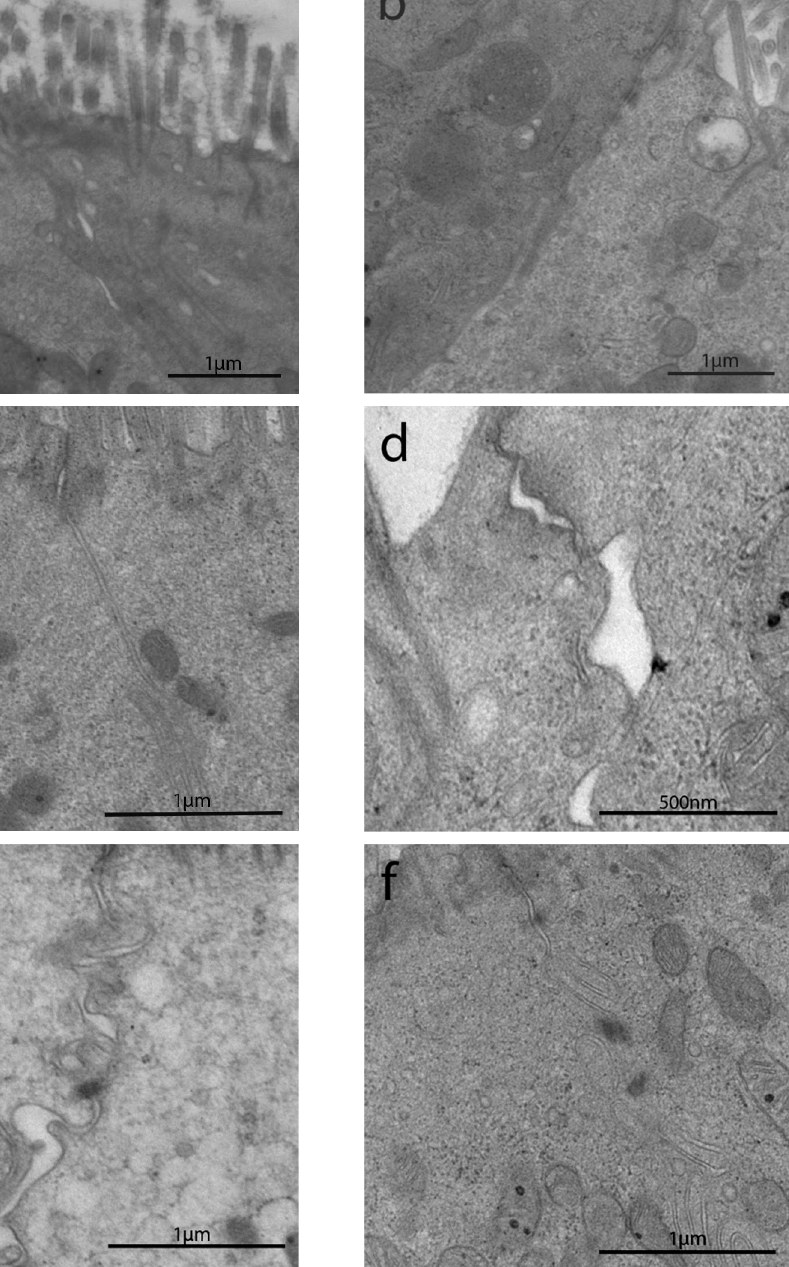
Figure 3. TEM images of apical junctional complexes (AJC) in IBS-like disorders: uCD ( a ); tCD ( b ); WA ( c ); NCGS ( d ); Ni ACM ( e ); controls ( f ). In particular, TJ gap width did not show significant differences among all groups; AJ gap was significantly more dilated in all groups compared to controls; desmosome gap was found significantly wider in uCD ( a ), NCGS ( d ) and Ni ACM ( e ) than all other groups.